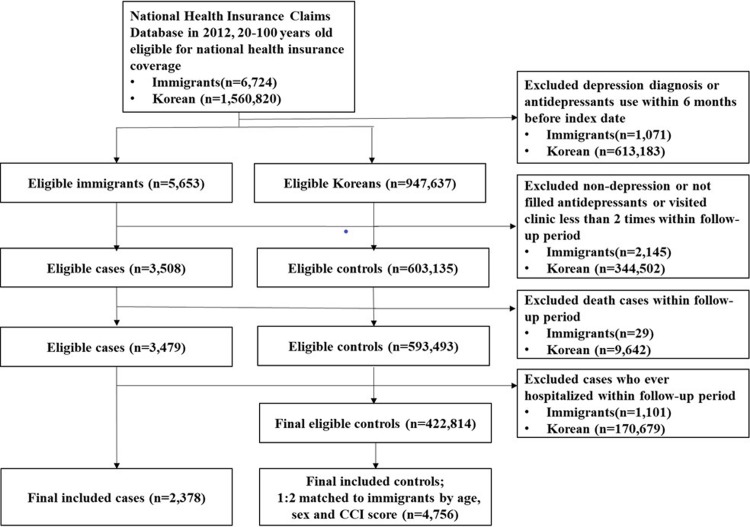
The selection process of study subjects; incident depression patients of immigrants and Korean.